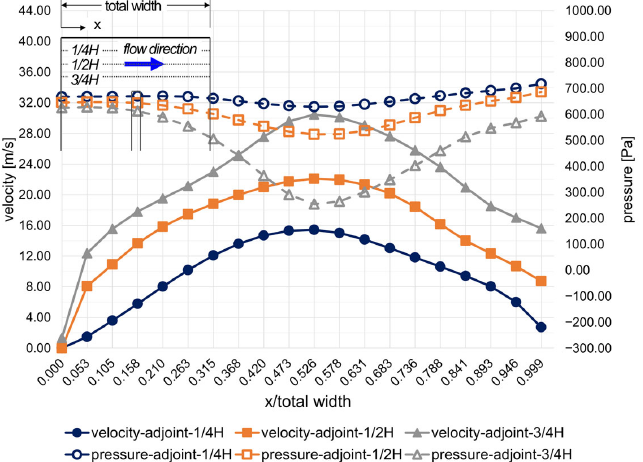
Figure 18. Flow characteristics in the turning region by the adjoint solver (Re = 24,230).